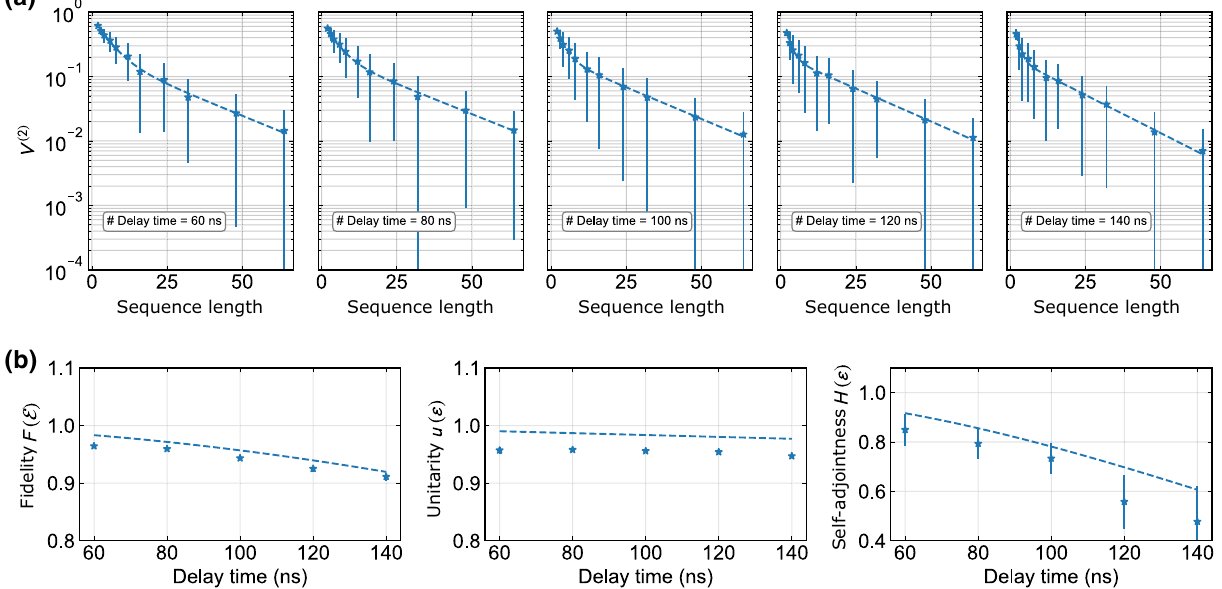
FIG. 5. (a) Experimental results for the single-qubit 2-RB on the qubit coupled to another qubit, where we sweep the interleaved delay time t . We have taken 100 random unitary sequences from I × m for each sequence length m and have had 10 4 measurements for each random sequence to take a data point of V ( 2 ) . The stars correspond to the values of V ( 2 ) and the dashed lines are fitting results. (b) Estimated values of F ( E t ) , u ( E t ) , and H ( E t ) obtained by the 2-RB. The stars show the fitting results, and the dashed lines are the predicted values from the phenomenological